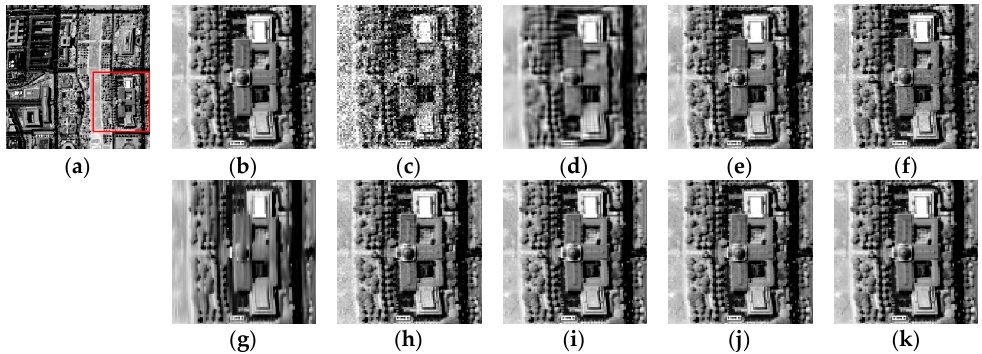
Figure 3. Denoising results for band 60 of Washington DC Mall data with Gaussian non-i.i.d. noise: (a ) Clean image; ( b ) zoomed area of clean image in red box of ( a ); ( c ) noisy image; ( d ) BM3D; ( e ) BM4D; ( f ) PCA + BM4D; ( g ) KSVD; ( h ) LRMR; ( i ) NAILRMA; ( j ) BPFA; and ( k ) HyDeSpDLS.